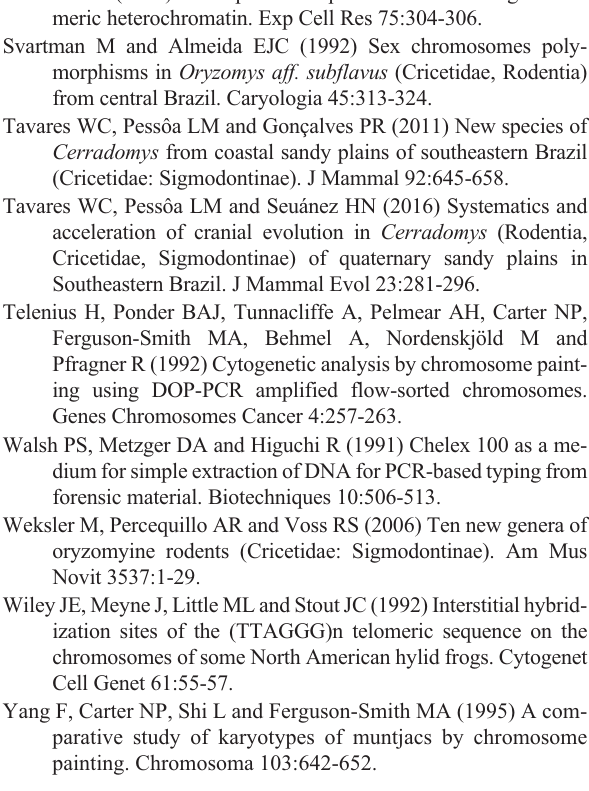
Table S1 - Specimens included in the molecular phylogeny with partial mitochondrial cytochrome b gene and sequences extracted from GenBank. Figure S1 - Maximum likelihood (ML) phylogenetic rela- tionships based on partial mitochondrial cytochrome b